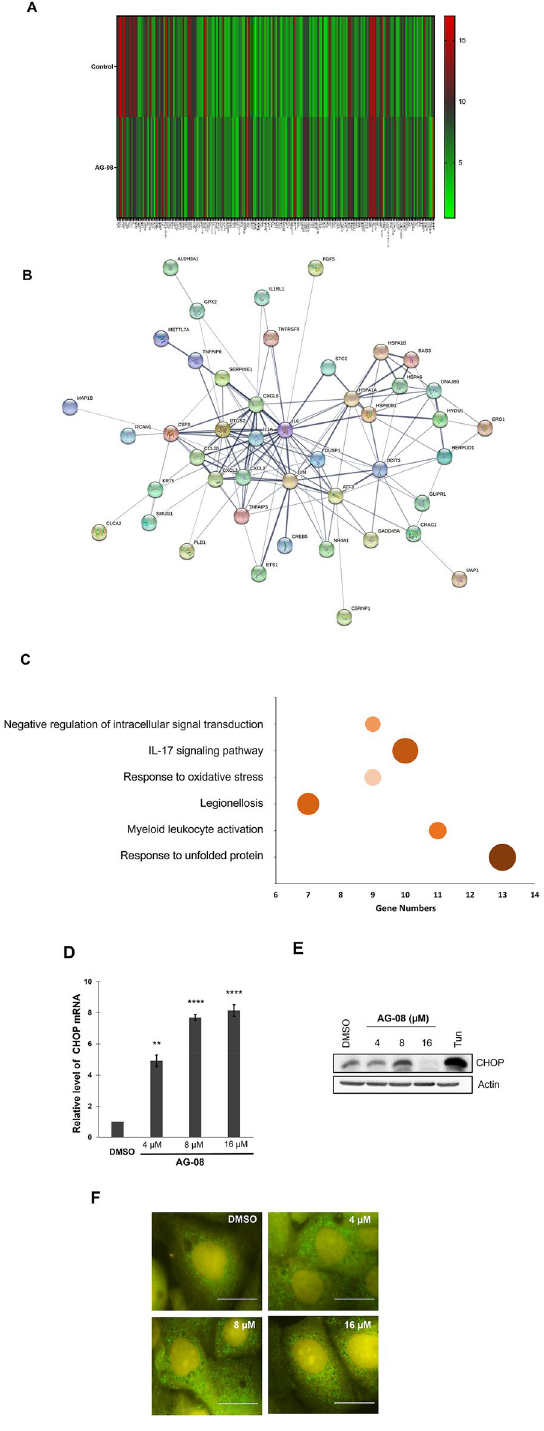
Figure 3. mRNA microarray analysis was used to identify differentially expressed genes via AG-08 treatment. ( A ) Heatmap representing the expressions of 193 genes with significant different expression in AG-08 treated cells compared with control. Heatmap was generated by GraphPad Prism version 8 (https:// www. graph pad. com/ scien tific- softw are/ prism/). ( B ) Protein–protein network analysis was formed via STRING. The thickness of the connecting lines indicates the strength of data support for physical and/or functional associations. ( C ) Pathway enrichment was determined using GO, KEGG, and Reactome pathway analysis. The figure displays six terms with the smallest p-values. Size of circle represents the significance of enrichment. ( D ) The protein levels of CHOP were determined via IB. 0.5 µg/ml tunicamycin (Tun) was used as positive control. The experiments were repeated three times independently; with one representative result shown. ( E ) mRNA level of the CHOP was investigated using quantitative PCR (q-RTPCR). Error bars represent standard error (s.e.). p-values were calculated with respect to vehicle-treated cells by one-way Anova test. (**p < 0.005, ****p < 0.0001). ( F ) The expression and localization of Calnexin protein were evaluated using immunofluorescence via anti-Calnexin antibody (scale bar 25